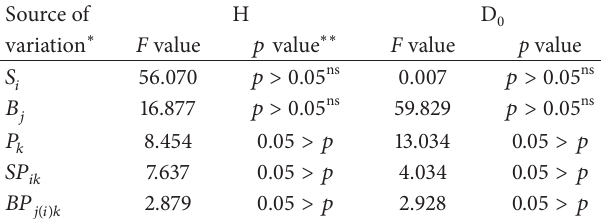
Table 3: Results of analysis of variance for the